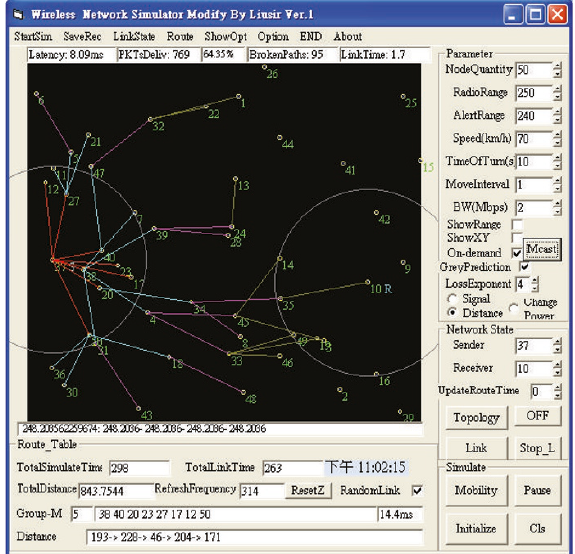
Figure 10: Simulations for